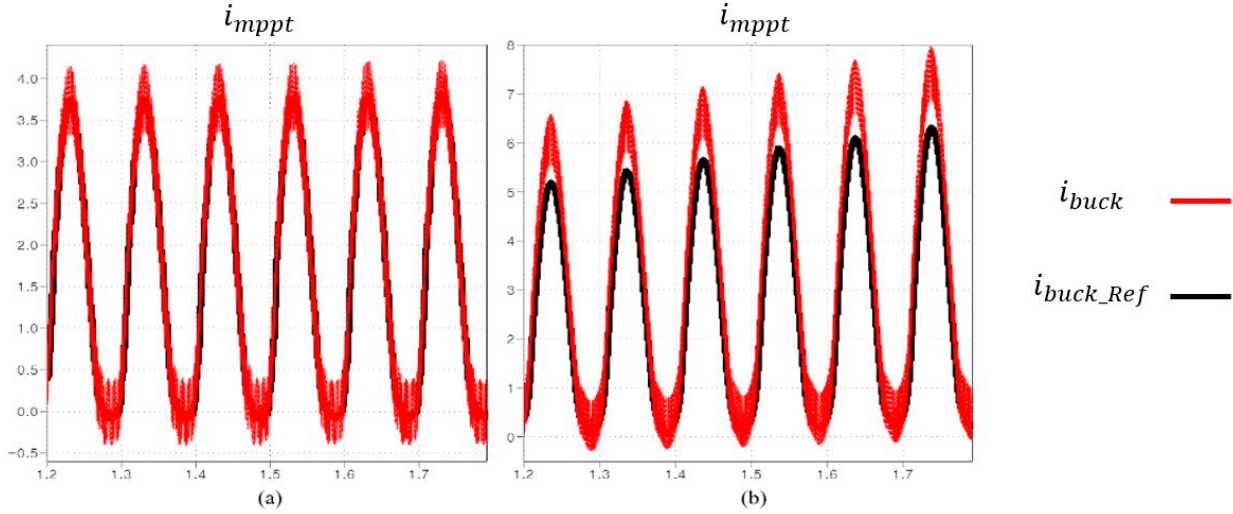
Figure 5. Simulation result of current variation under discrete torque ( a ) proposed step size ( b ) fixed step size.